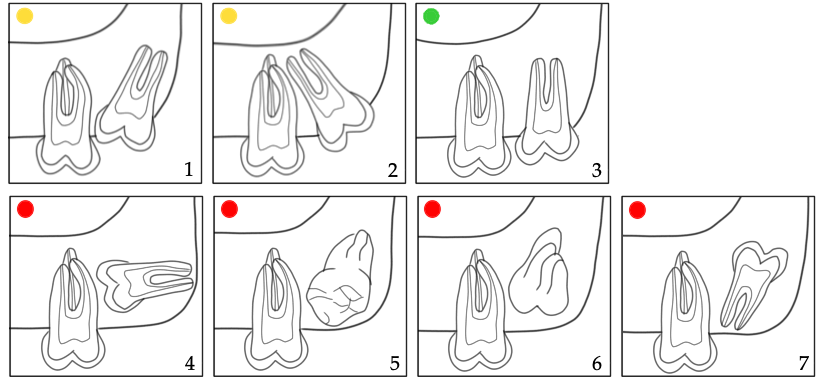
Figure 2. Archer’s (horizontal) classification for the inclination of the maxillary M3 relative to the longitudinal axis of M2 [23]. Subdivision according to the eruption prognosis of M3 in 1 , 2 : questionable ( ); 3 : good ( ); 4 – 7 : bad prognosis ( ).